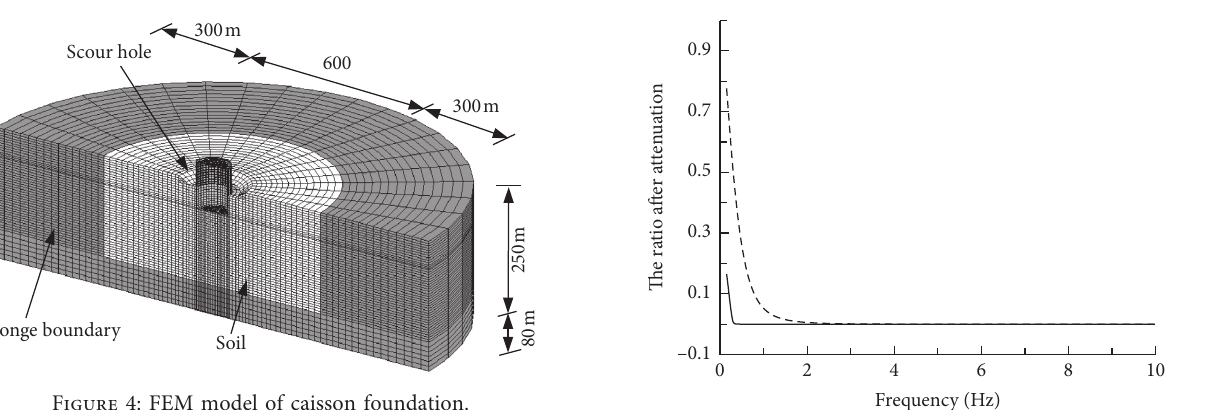
Figure 4: FEM model of caisson foundation.